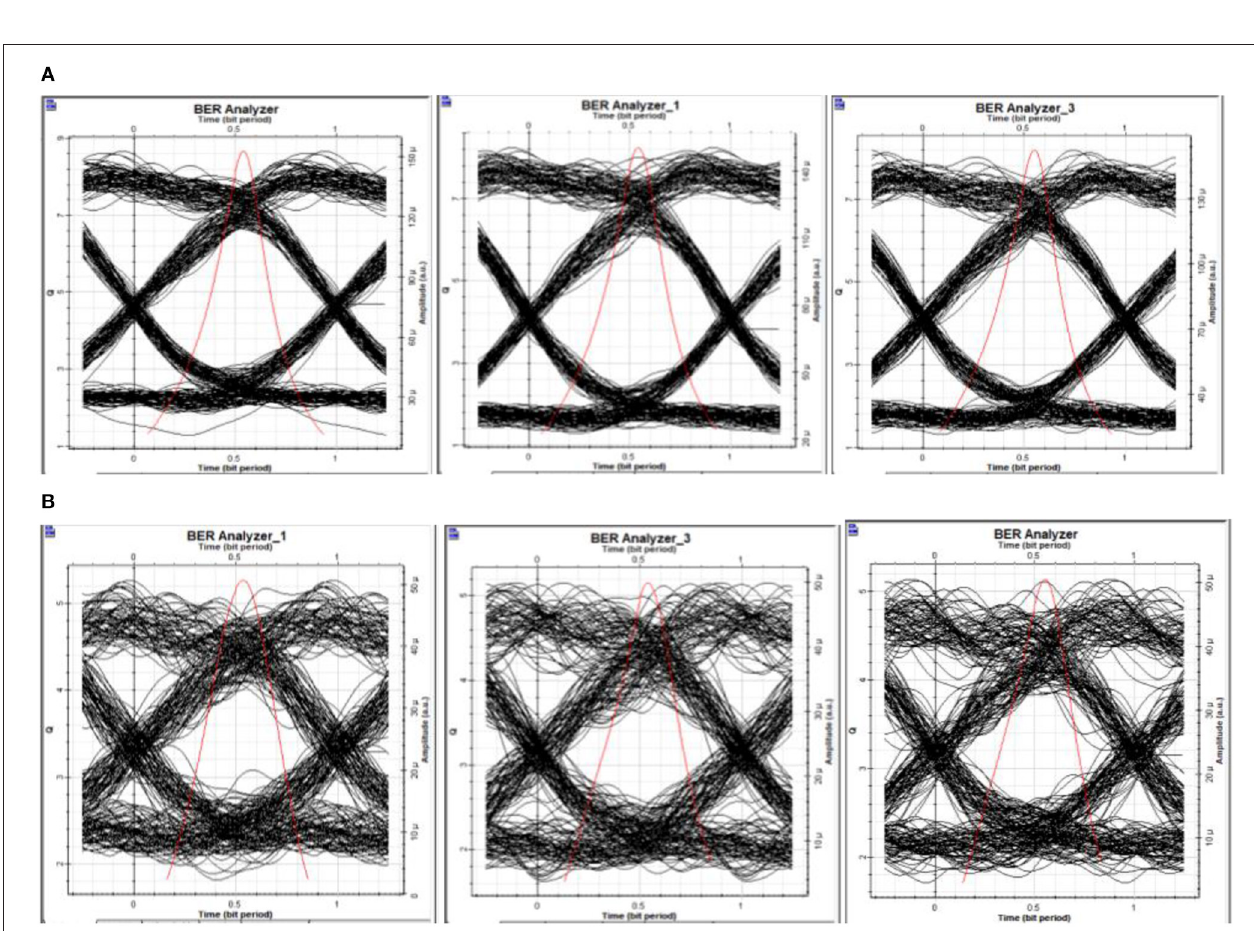
FIGURE 5 | The eye diagrams for conventional WDM-based RoF system for 50 GHz channel spacing. (A) The eye diagrams at channels 1, 8, and 16 at − 5 dBm input power. (B) The eye diagrams at channels 1, 8, and 16 at − 15 dBm input power.